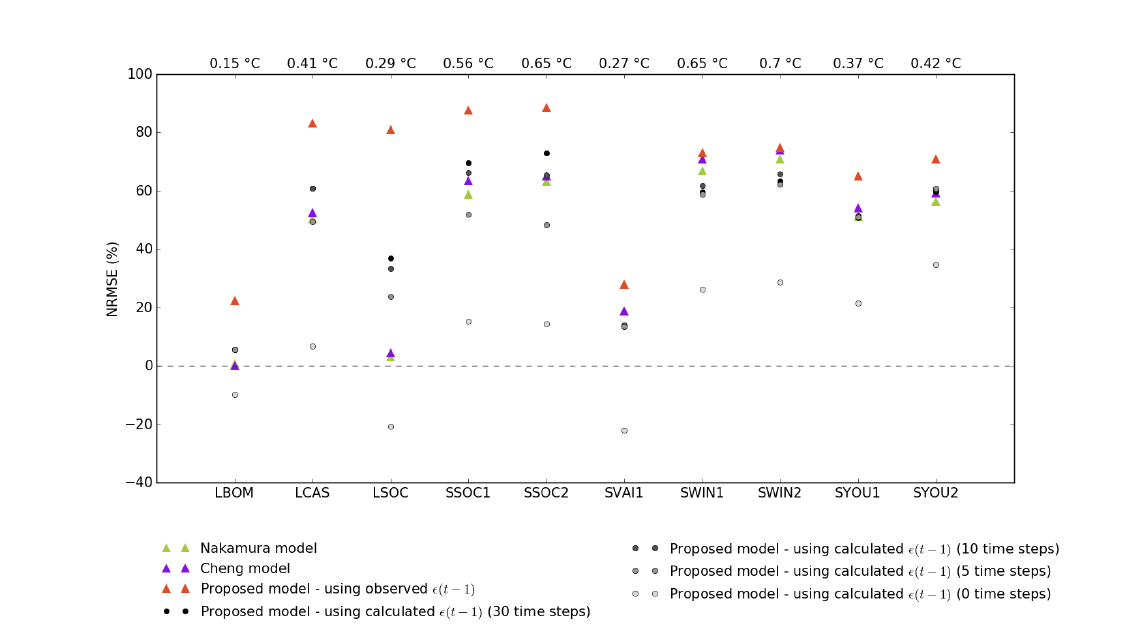
Figure 13. NRMSE values observed for each model and each shelter considering all day-time values. The RMSE of each shelter is indicated on the top